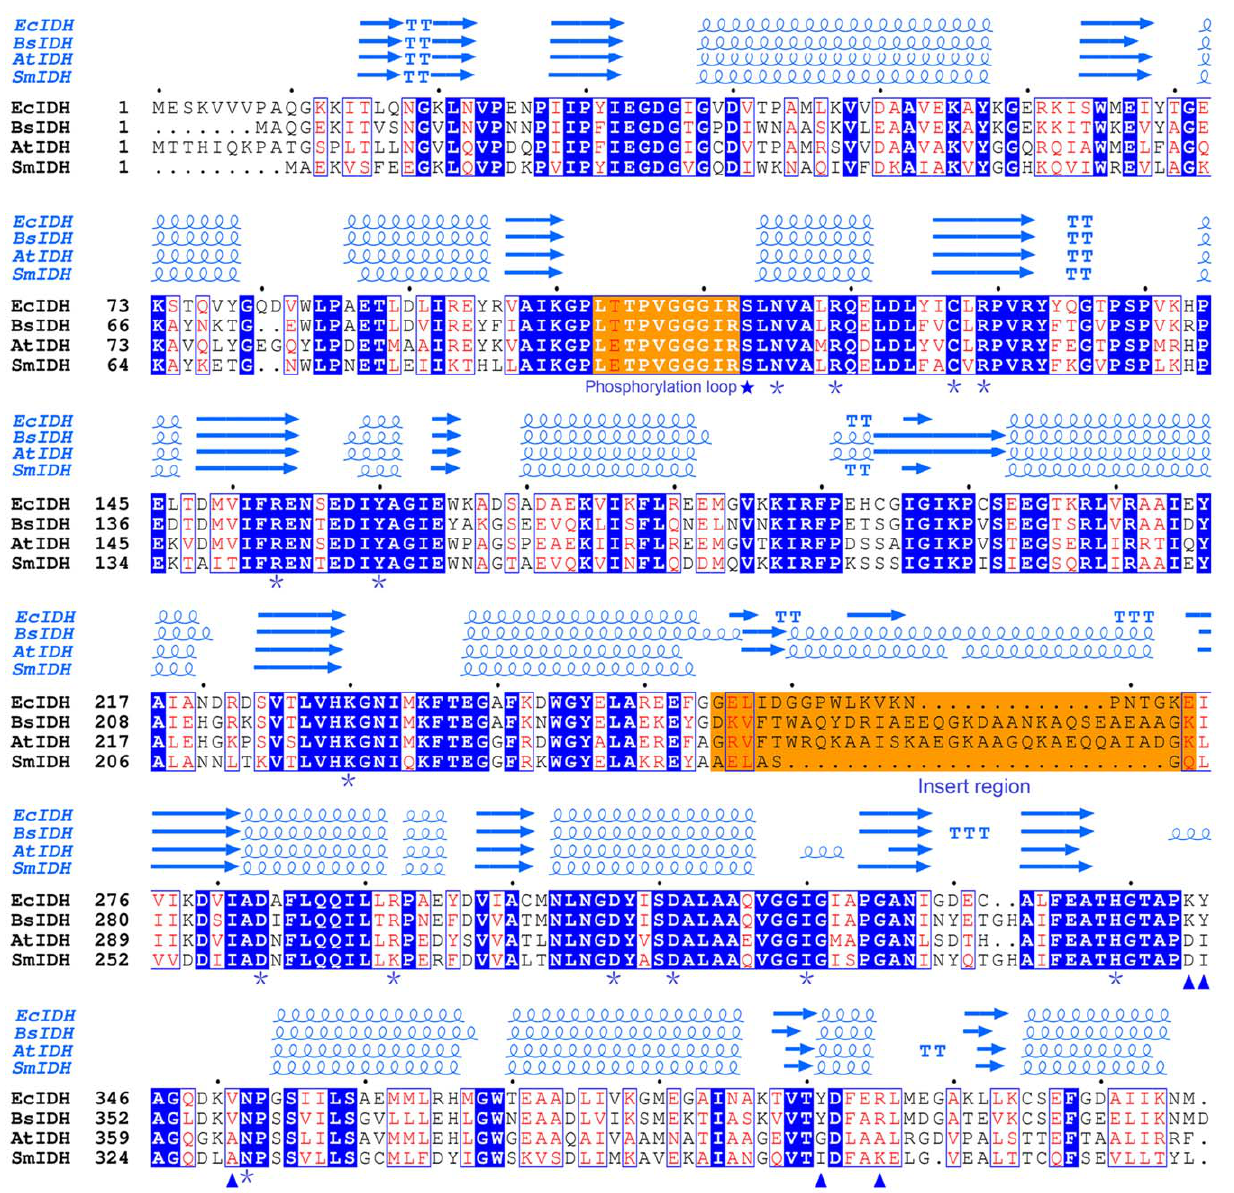
Figure 4. Structure-based protein sequence alignment of SmIDH with other dimeric IDHs. High-resolution crystal structures of E. coli NADP-IDH (EcIDH, 9ICD), B. subtilis NADP-IDH (BsIDH, 1HQS) and A. thiooxidans NAD-IDH (AtIDH, 2D4V) were downloaded from the PDB database. SmIDH structure was generated using the SWISS-MODEL modeling server, using AtIDH as a template structure. Invariant residues are highlighted by shaded blue boxes and conserved residues by open blue boxes. The conserved residues involved in the cofactor binding ( m ) and substrate binding (*) are indicated. The phosphorylation site was represented by w . The phosphorylation loop and the insert region were highlighted by shaded orange boxes. The figure was made with ESPript 2.2